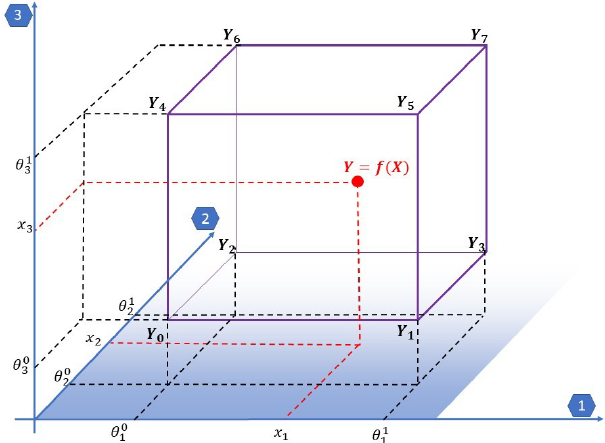
Figure 1. Description of variables for N = 3 with a regular grid